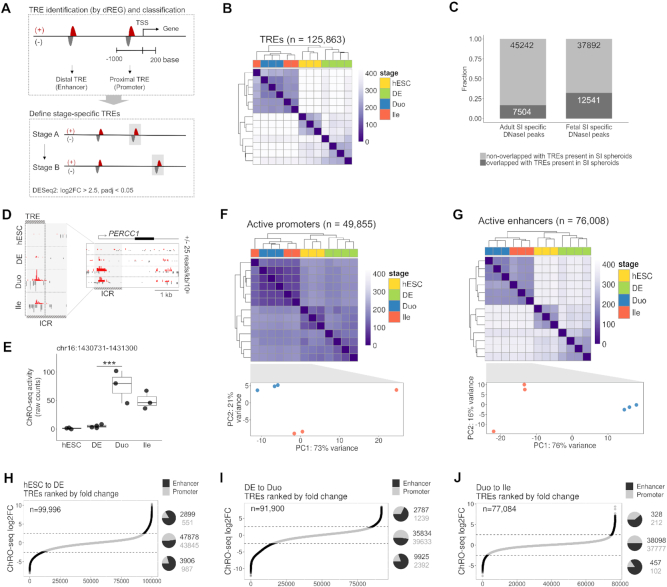
TRE profiles reveal notable re-wiring of chromatin activity in the directed differentiation model of human developing SI. (A) Schematic for identification and categorization of active TREs, followed by definition of TREs with altered activity during stage transitions of the model. (B) Hierarchical clustering analysis of profiles of all active TREs. (C) Fraction of fetal and adult SI-specific open chromatin regions (defined according to DNaseI-seq data from the Roadmap Epigenomics Project) overlapping with active TREs present in Duo and/or Ile spheroids. (D) ChRO-seq signal around the ICR (49). An active TRE identified in our study (chr16: 1430731–1431300; hg38) largely overlaps with the ICR and exhibits strong ChRO-seq signals in SI spheroids. Scales in right panel (+25/−25) and left panel (+166/−15; the maximum range) are fixed across different stages. (E) The transcriptional activity of the TRE associated with the ICR (chr16: 1430731–1431300; hg38) across all stages of the model (*** P < 0.001 by Wald test; DESeq2). (F) Hierarchical clustering (upper) and PCA (lower) analysis of promoter profiles in the indicated stage. (G) Hierarchical clustering (upper) and PCA (lower) analysis of enhancer profiles in the indicated stage. (H) Active TREs present in hESC and DE (n = 99996) and ranked based on the log2 fold change in activity during the transition to DE. (I) Active TREs present in DE and Duo spheroid (n = 91900) and ranked based on the log2 fold change in activity during Duo spheroid formation. (J) Active TREs present in Duo and Ile spheroid (n = 77084) and ranked based on the log2 fold change in activity during Ile spheroid formation. In (H–J), the proportion and the number of promoters and enhancers that are gained (pie chart on the top), unchanged (pie chart in middle) or lost (pie chart at the bottom) are indicated in each stage transition. hESC, n = 3; DE, n = 4; Duo spheroid (Duo), n = 3; Ile spheroid (Ile), n = 3.